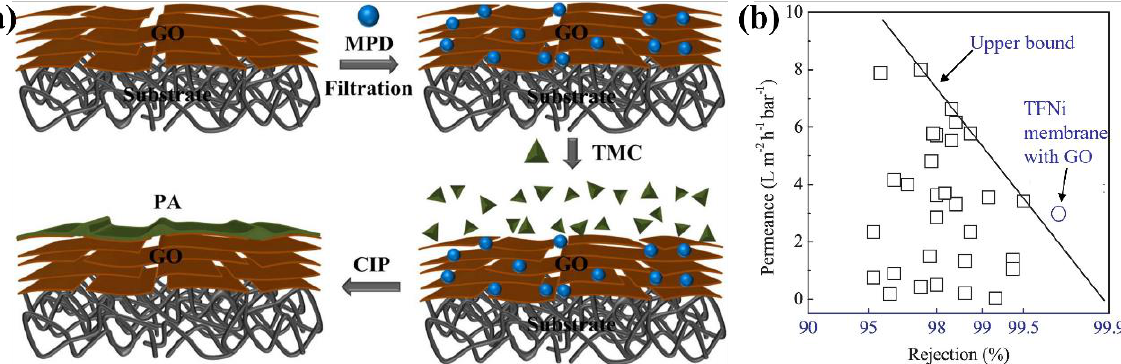
Figure 2. ( a ) Schematic illustration of TFNi membrane with GO nanosheets via confined interfacial polymerization, ( b ) Comparison of the prepared TFNi membrane with other RO membranes (The squares were the published RO membrane, and the circle was TFNi membrane with GO), reproduced with permission from Ref. [59] with copyright permission from © 2018 Elsevier.